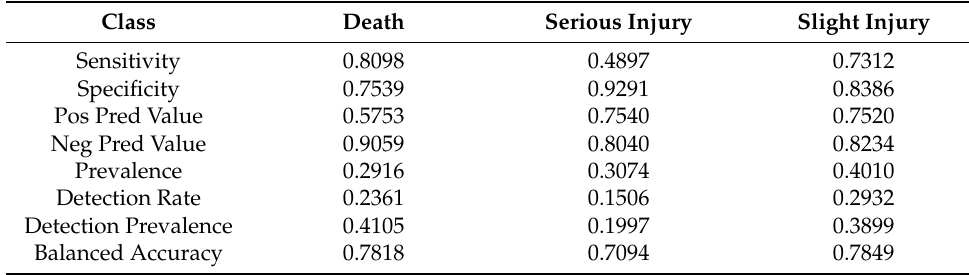
Figure 3. Variable importance ranking for the extended decision tree. Table 4. Detailed measures for the individual injury